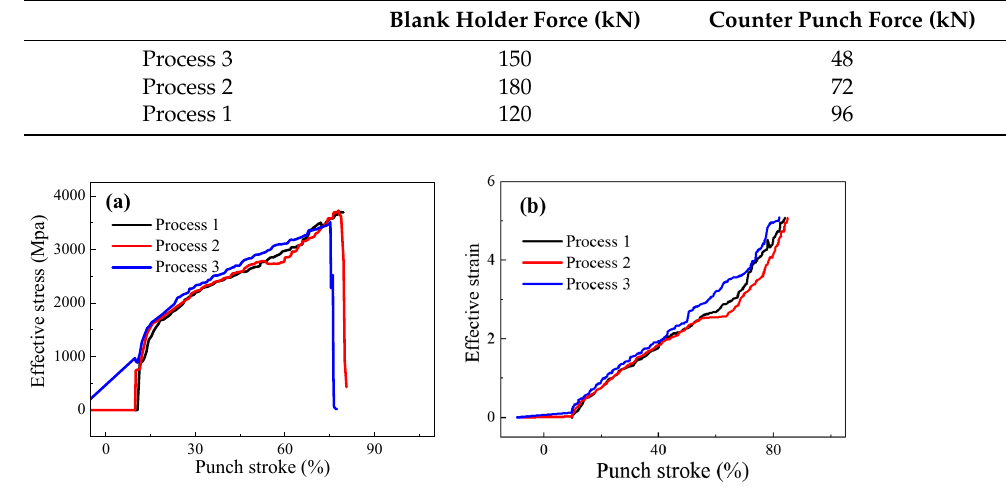
Figure 12. Equivalent stress and strain data of three sets of simulations: ( a ) the equivalent stress changes; ( b ) the equivalent strain changes.